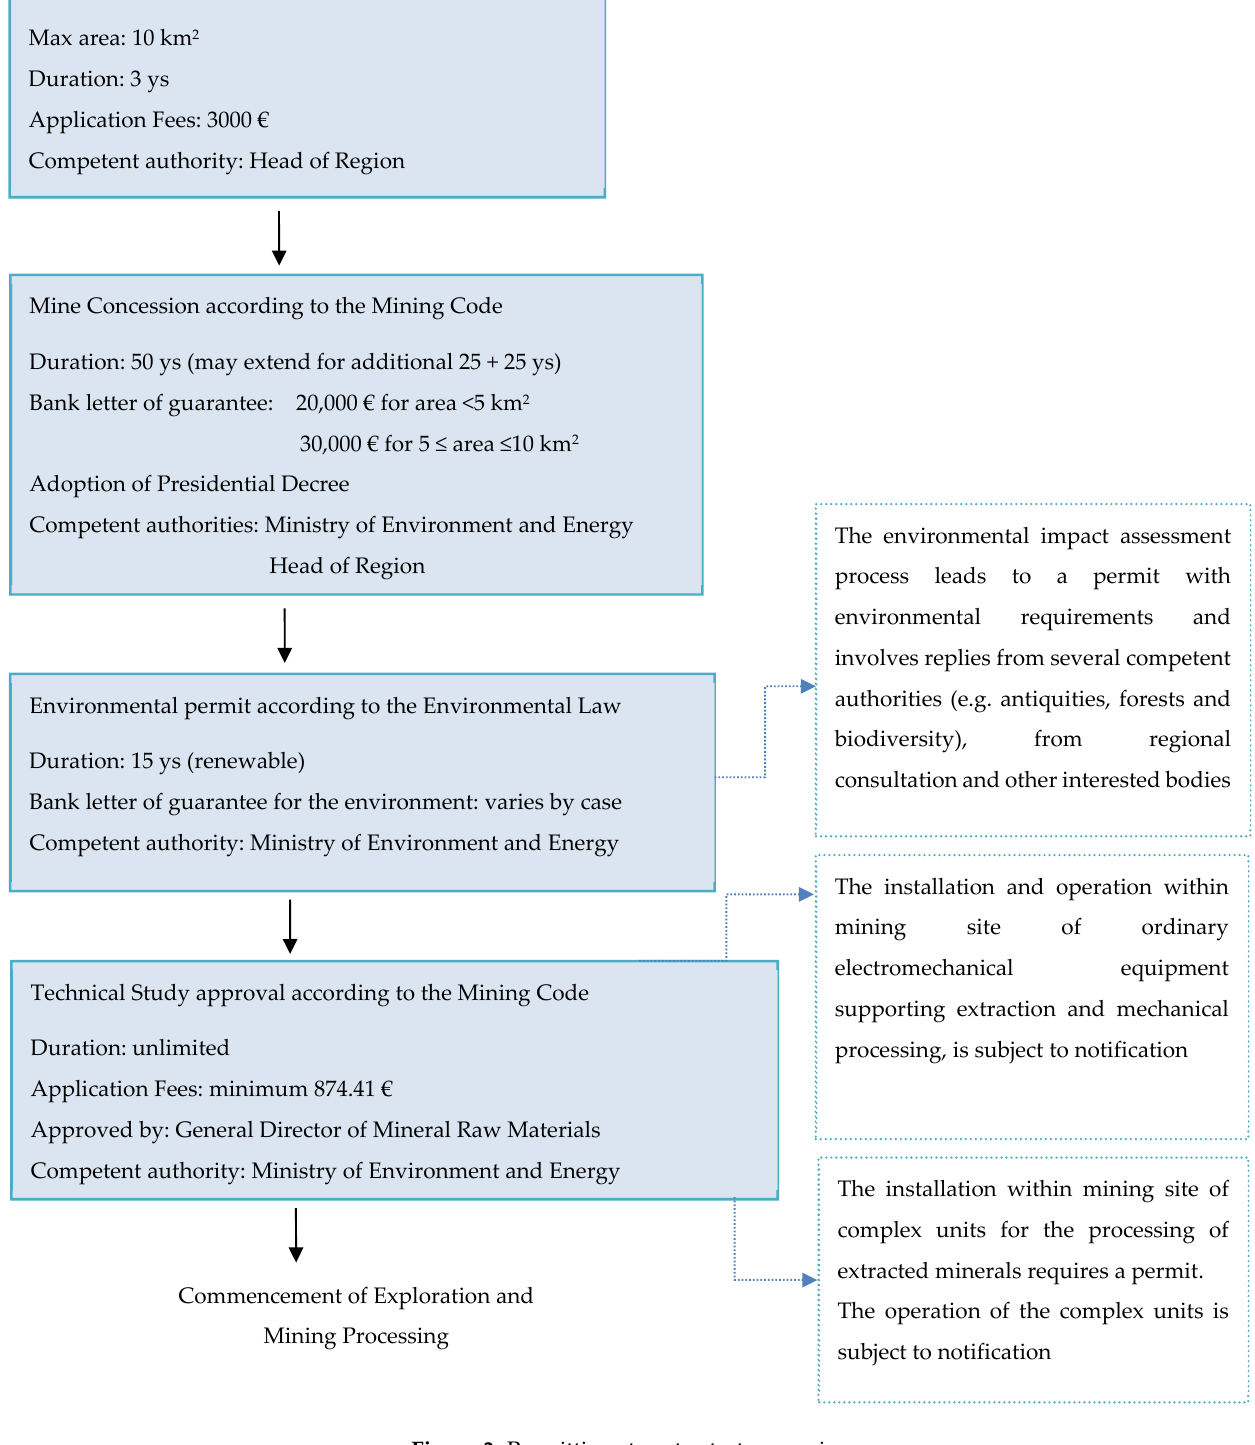
Figure 3. Permitting steps to start up a mine.